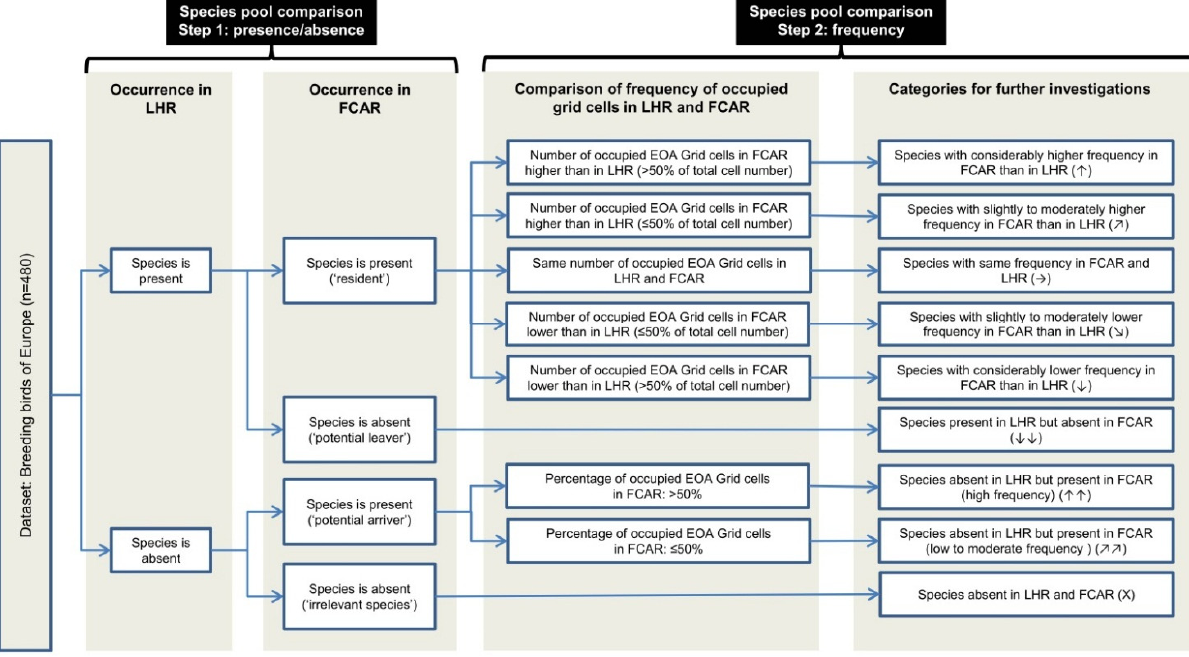
Figure 2. Concept for species pool comparisons. LHR: Lüneburg Heath region; FCAR: Future climatically analogous region; EOA: European Ornithological Atlas